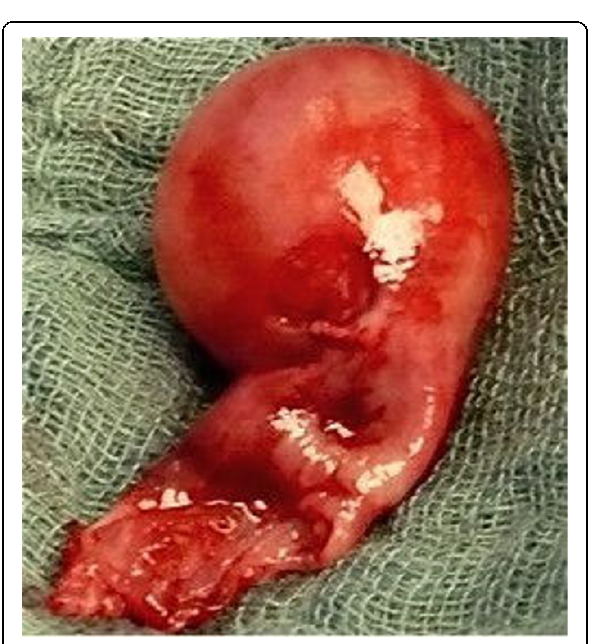
Figure 2 Surgical specimen . Upon removal the mass revealed a well defined tumour originating with a narrow pedicle from the papilla of the lower chalice